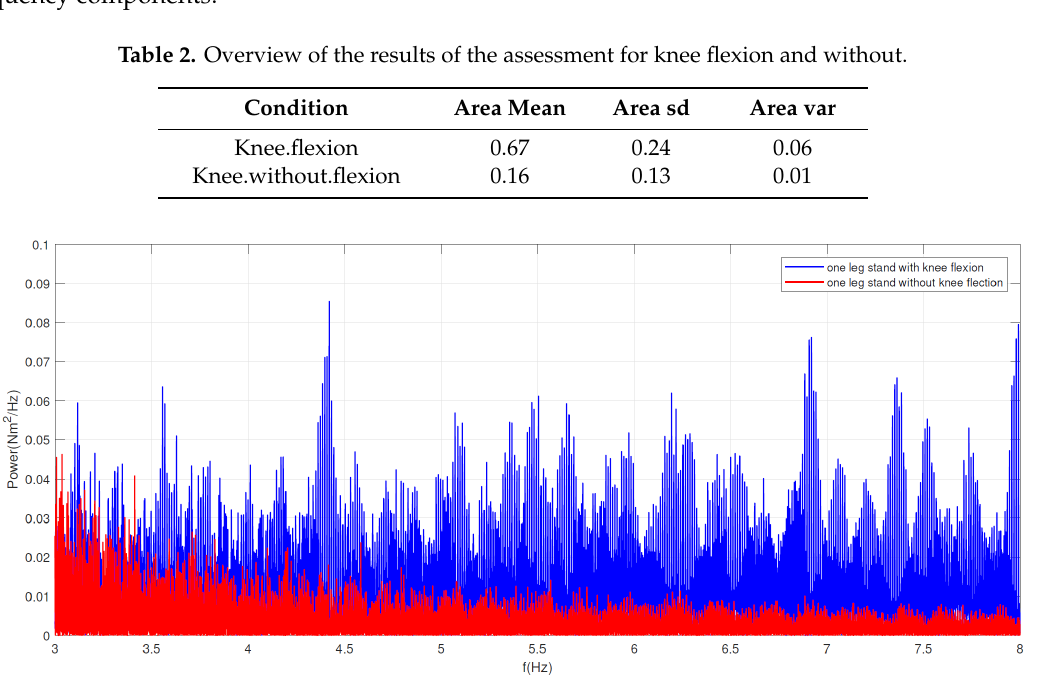
Figure 4. Comparison of center of pressure (CoP) measurements with and without knee flexion. Blue: power spectral density (PSD) spectrum of the test persons with knee flexion; red: PSD spectrum of the test persons without knee flexion.